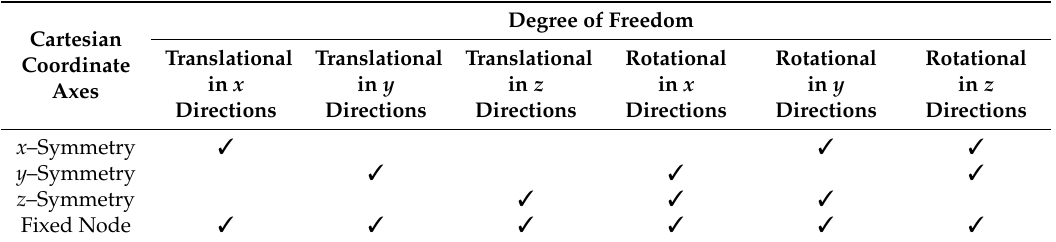
Table 4. Degrees of freedom at modelling of open-cell aluminium foam.